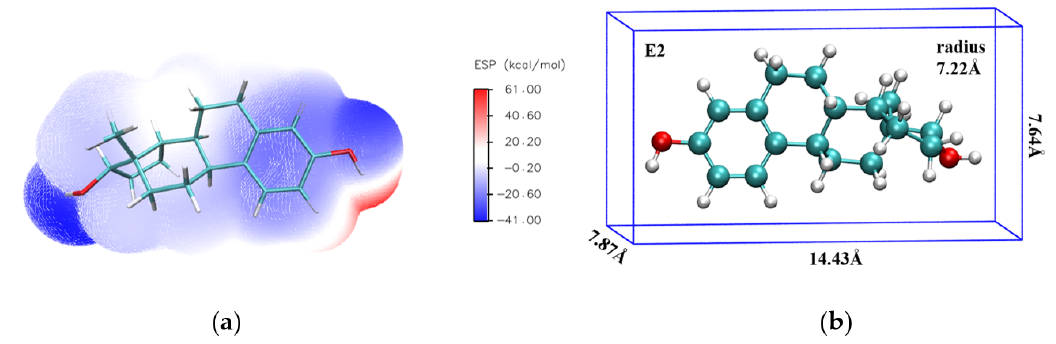
Figure 6. Electrostatic potential (ESP) energy ( a ); Three dimensions of E2 after density functional theory (DFT) optimization ( b ).